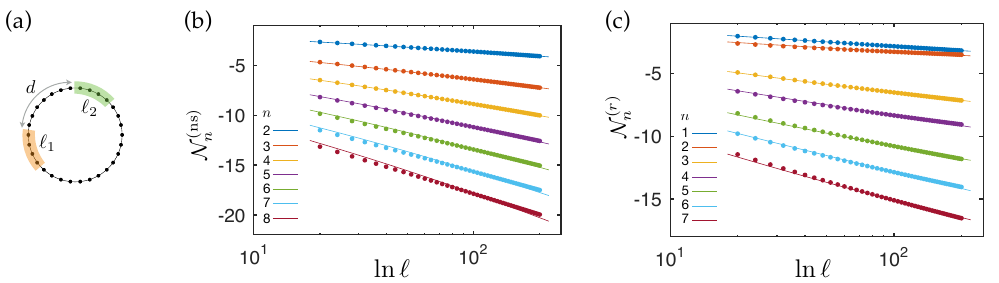
Figure 7: Comparison of numerical (dots) and analytical (solid lines) results for the scaling behavior of the moments of partial transpose (48) and (50) for two disjoint intervals (the geometry is shown in panel (a)). Here, d = 40 and intervals have = (cid:96) = (cid:96) where 20 ≤ (cid:96) ≤ 200 on an infinite chain. The analytical equal lengths (cid:96) 1 2 results are given by Eq. (122) in panel (b) and Eq. (128) in panel(c). Different colors correspond to different moments n